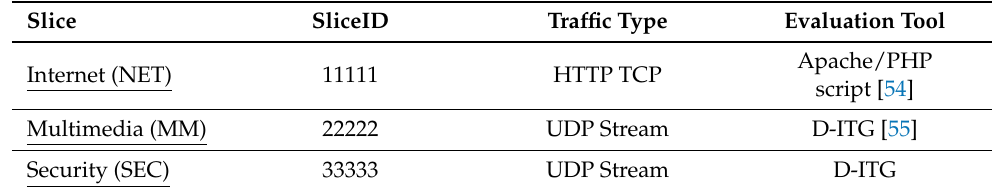
Table 2. Slice traffic